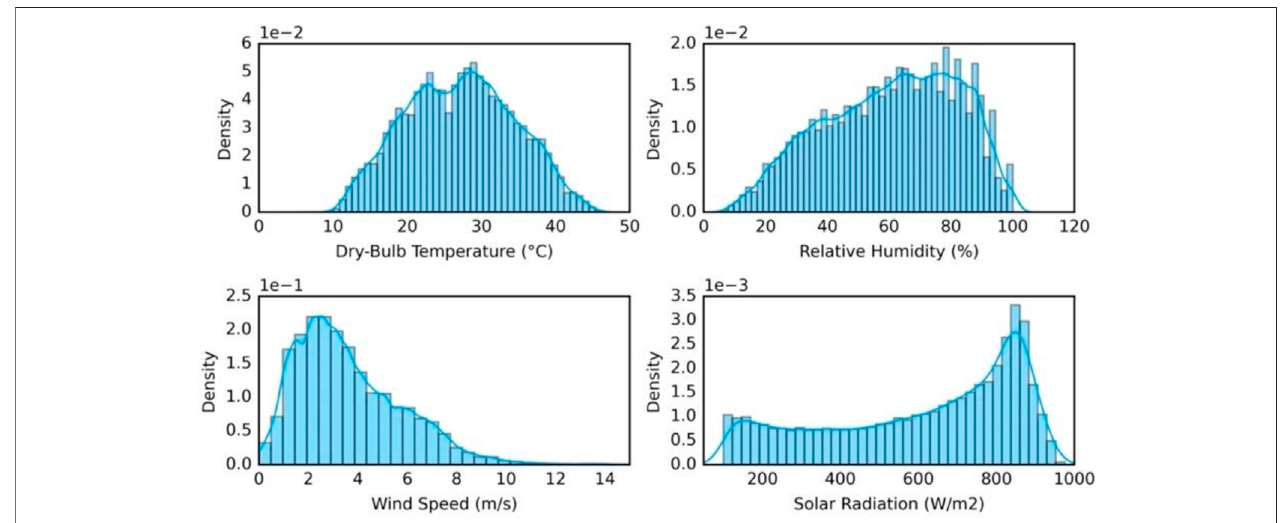
FIGURE 3 | Frequency density of historical weather data representing dry-bulb temperature, relative humidity, wind speed, and solar radiation used in the building simulation.